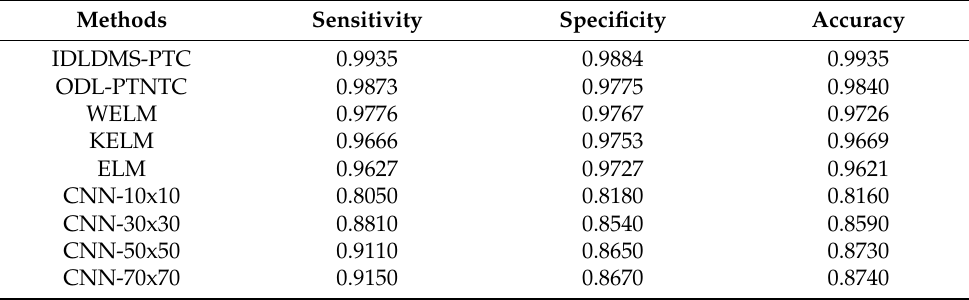
Table 3. Comparative analysis of IDLDMS-PTC technique with recent